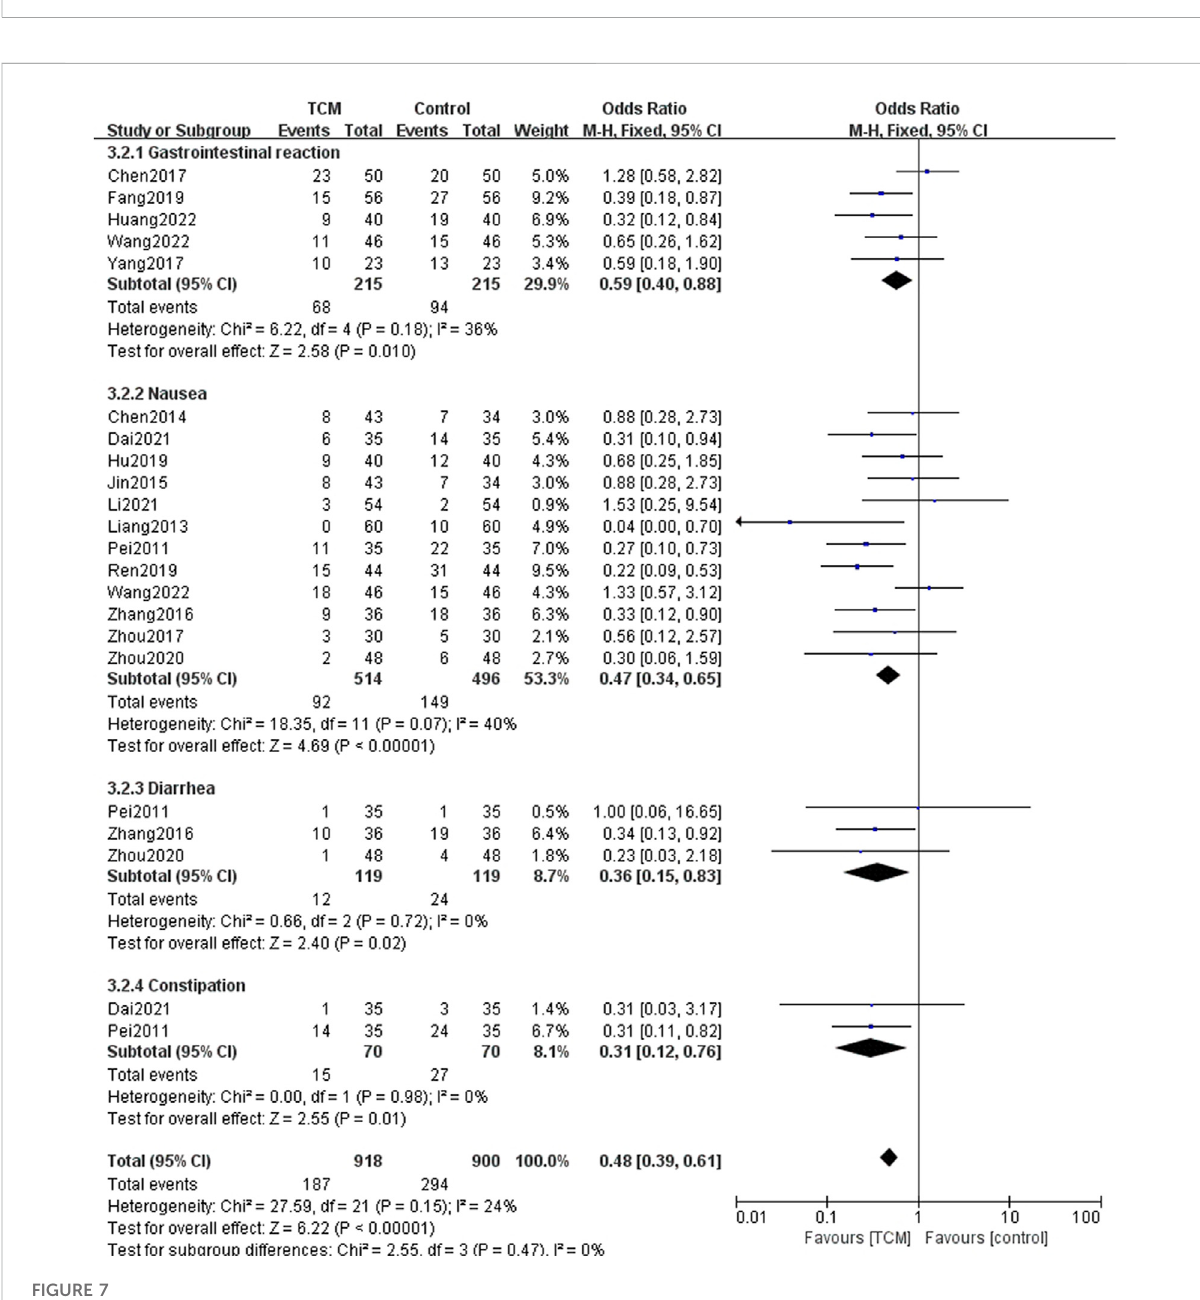
FIGURE 7 Forest plots and subgroup analysis for gastrointestinal adverse